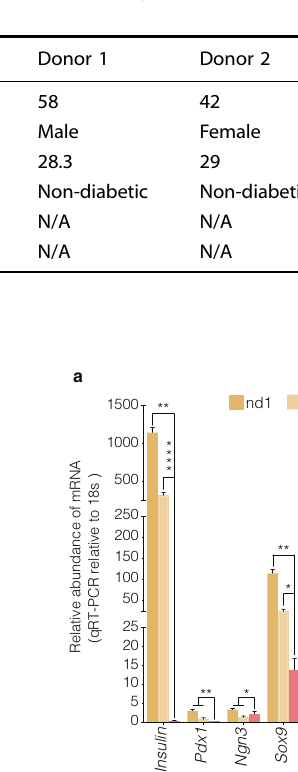
Table 1. Clinical characteristics of type 1 diabetic and non-